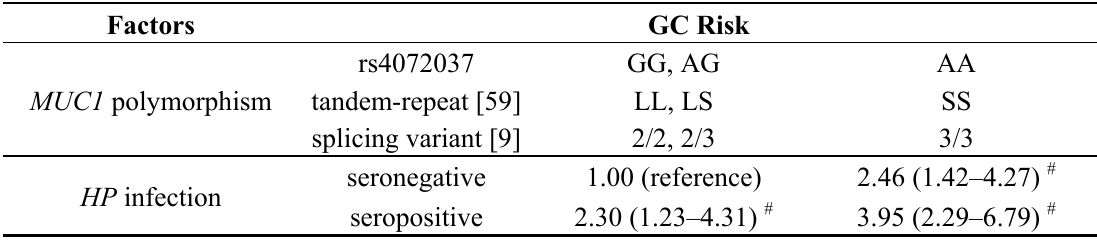
Table 3. Effect of HP ( Helicobacter pylori) infection and MUC1 polymorphism on GC risk